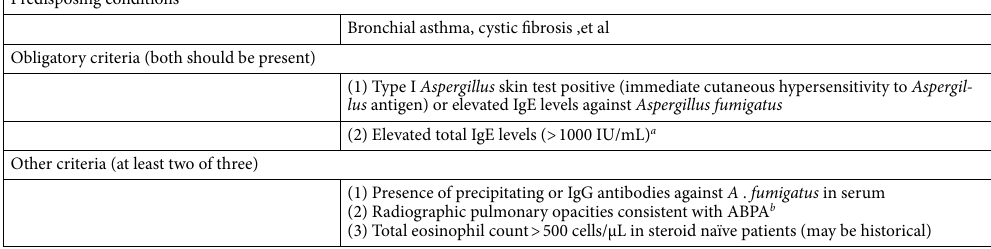
Table 1. Newly proposed diagnostic criteria for allergic bronchopulmonary aspergillosis. a If the patient meets all other criteria, an IgE value < 1000 IU/mL may be acceptable. b The chest radiographic features consistent with ABPA may be transient (i.e. consolidation, nodules, tram ‐ track opacities, toothpaste/finger ‐ in ‐ glove opacities, fleeting opacities) or permanent (i.e. parallel line and ring shadows, bronchiectasis and pleuropulmonary fibrosis).